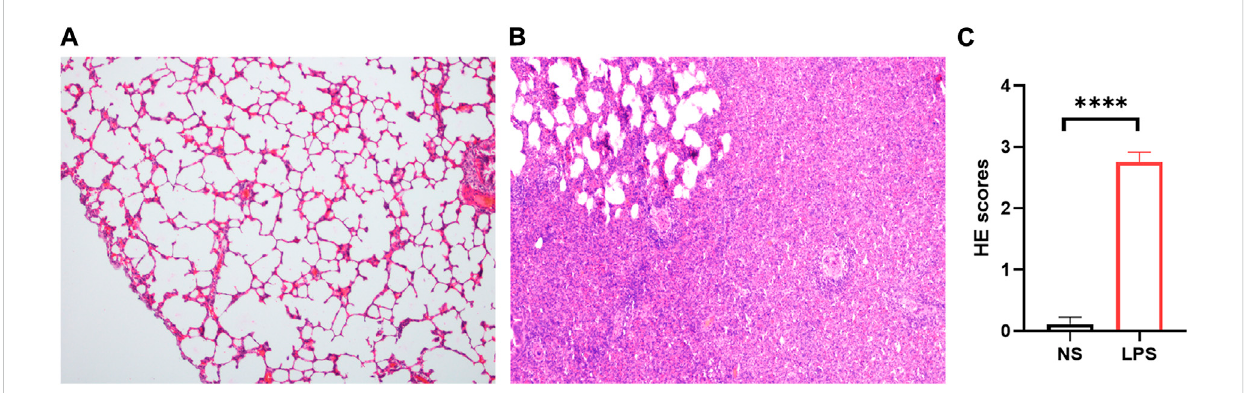
FIGURE 3 H&EstainingofcontrolandLPS-inducedARDSrats. (A) .Controlgroup,magni fi cation×100. (B) .LPSgroup,magni fi cation×100. (C) .HEscoresofthe control and LPS